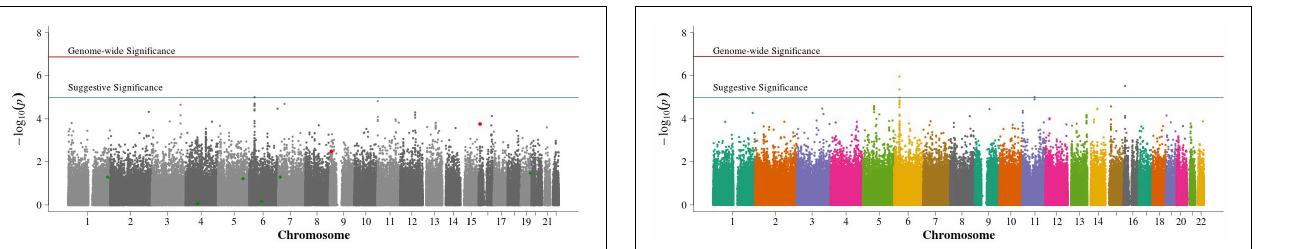
FIGURE 5 | Manhattan plot for Fisher’s combined probability of population- and family-based studies. Summary of genome-wide association scan results in the GoKinD collection of combined probability of the population-based and family-based P -values. The − log 10 P -values were calculated for SNP association with diabetic nephropathy among subjects with type 1 diabetes by combining each study P -values using Fisher’s combined probability method. Power ranking was obtained using conditional mean model for family-based data and data partitioning for population-based cases and controls. Rankings were obtained for each subset and then log transformed and summed. The top ten ranked SNPs were tested; the two SNPs significant at 0 . 05 / 10 = 0 . 005 are indicated in red, while the other eight are in green. The red horizontal line corresponds to genome-wide significance ( P -value = 0 . 05 / 374 , 042 = 1 . 3 × 10 − 7 ). The blue horizontal line corresponds to suggestive significance ( P -value = 1 × 10 − 5 ).